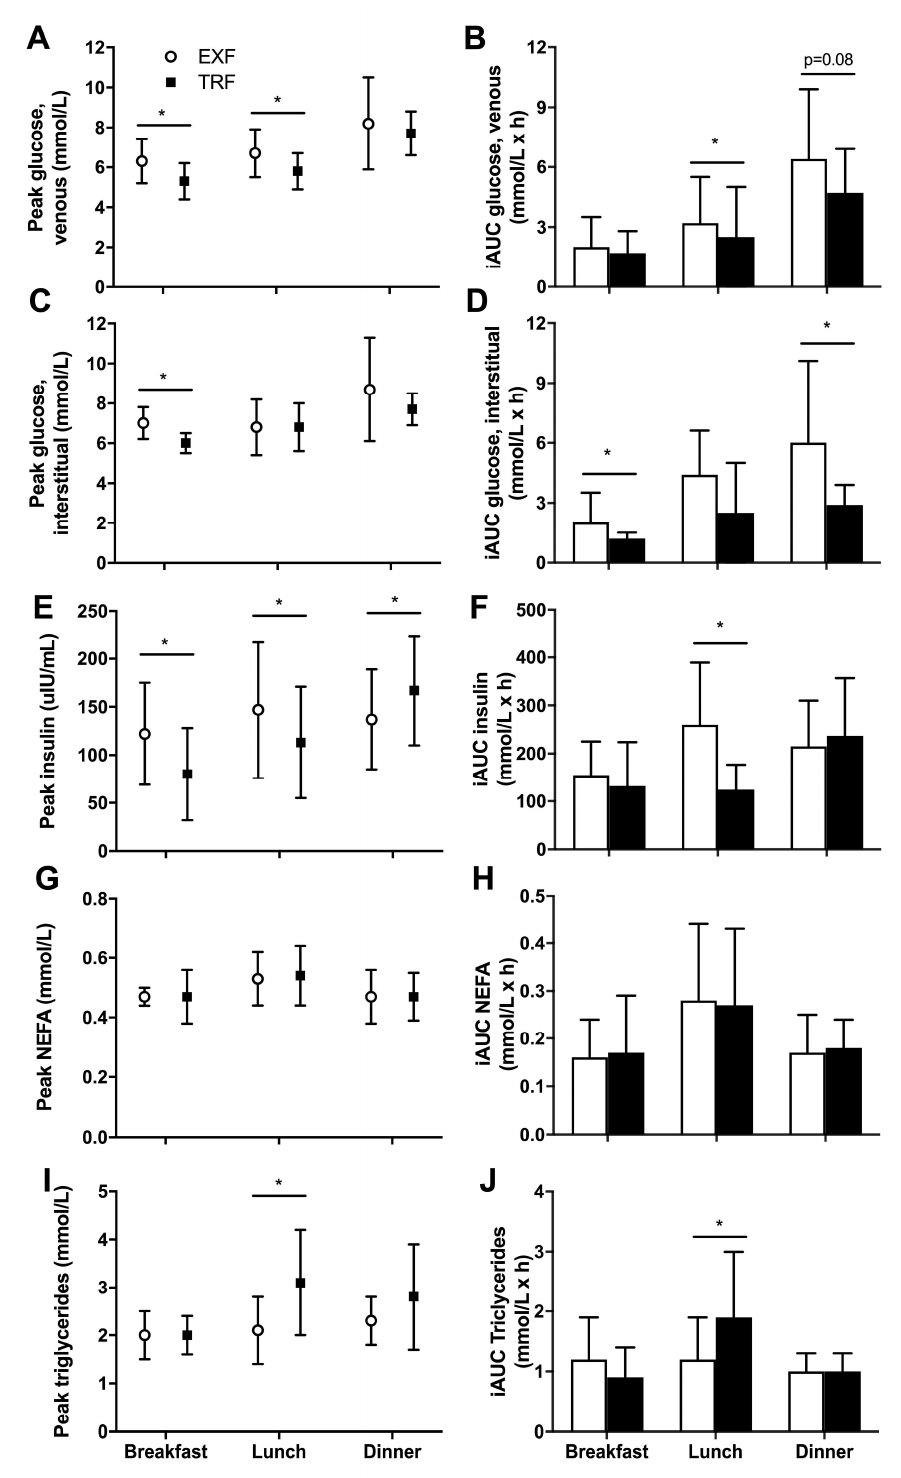
Figure 4. Three-hour postprandial meal peak and incremental area under the curve (iAUC) glucose (venous, A–B , and interstitial (CGMS), C–D ), insulin ( E–F ), non-esterified fatty acids (NEFA, G–H ) and triglyceride ( I–J ) concentrations for breakfast, lunch and dinner periods from participants with overweight/obesity (n = 10) throughout trial conditions of time-restricted feeding (TRF; black squares and bars) and extended feeding (EXF; white circles and bars). Black triangles represent TRF mealtimes whereas grey triangles represent EXF mealtimes. Data are mean ± SD. P < 0.05 for * main effect of condition.